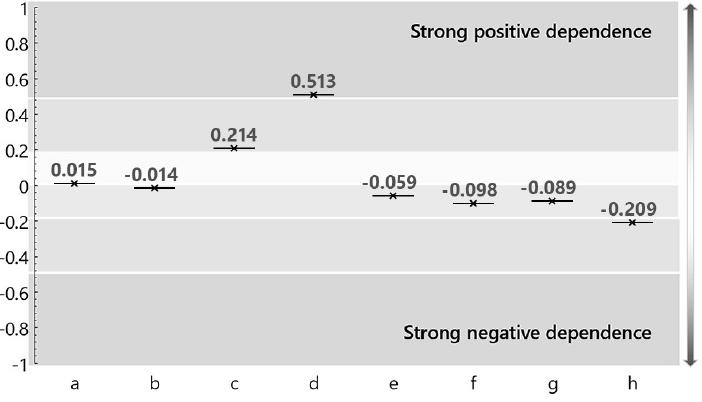
Figure 6. Standardized coefficients